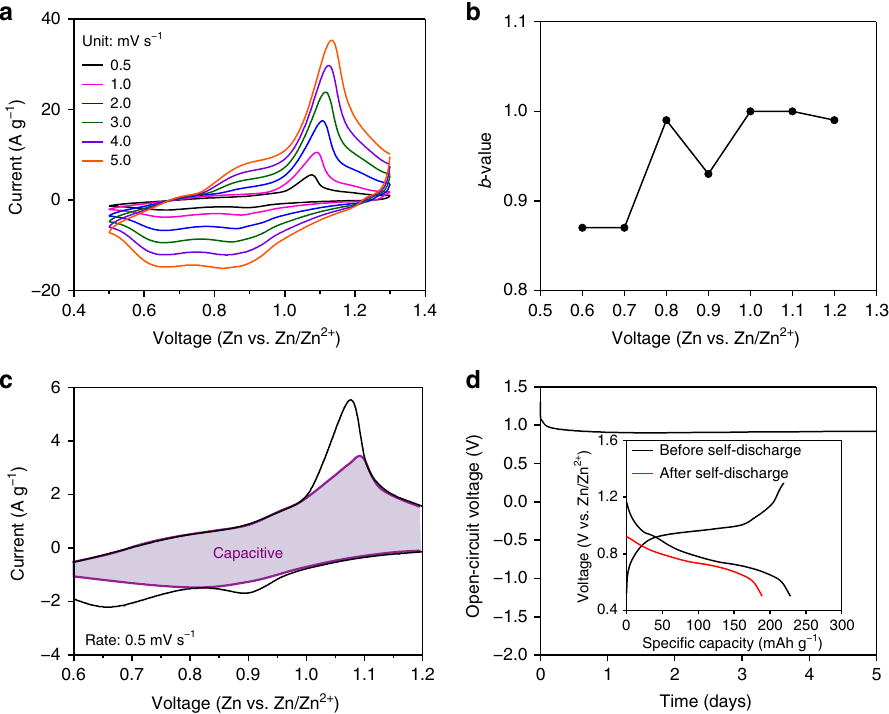
Fig. 6 Charge-storage mechanism of Cu 3 (HHTP) 2 . a Cyclic voltammograms of Cu 3 (HHTP) 2 recorded at different scan rates. b b -values for the Cu 3 (HHTP) 2 electrodes plotted as a function of the potential for cathodic scans. c Capacitive and diffusion currents contributed to the charge-storage of Cu 3 (HHTP) 2 at the rate of 0.5 mV s − 1 . d A self-discharge pro fi le of Cu 3 (HHTP) 2 . The inset shows voltage pro fi les for the self-discharge test before